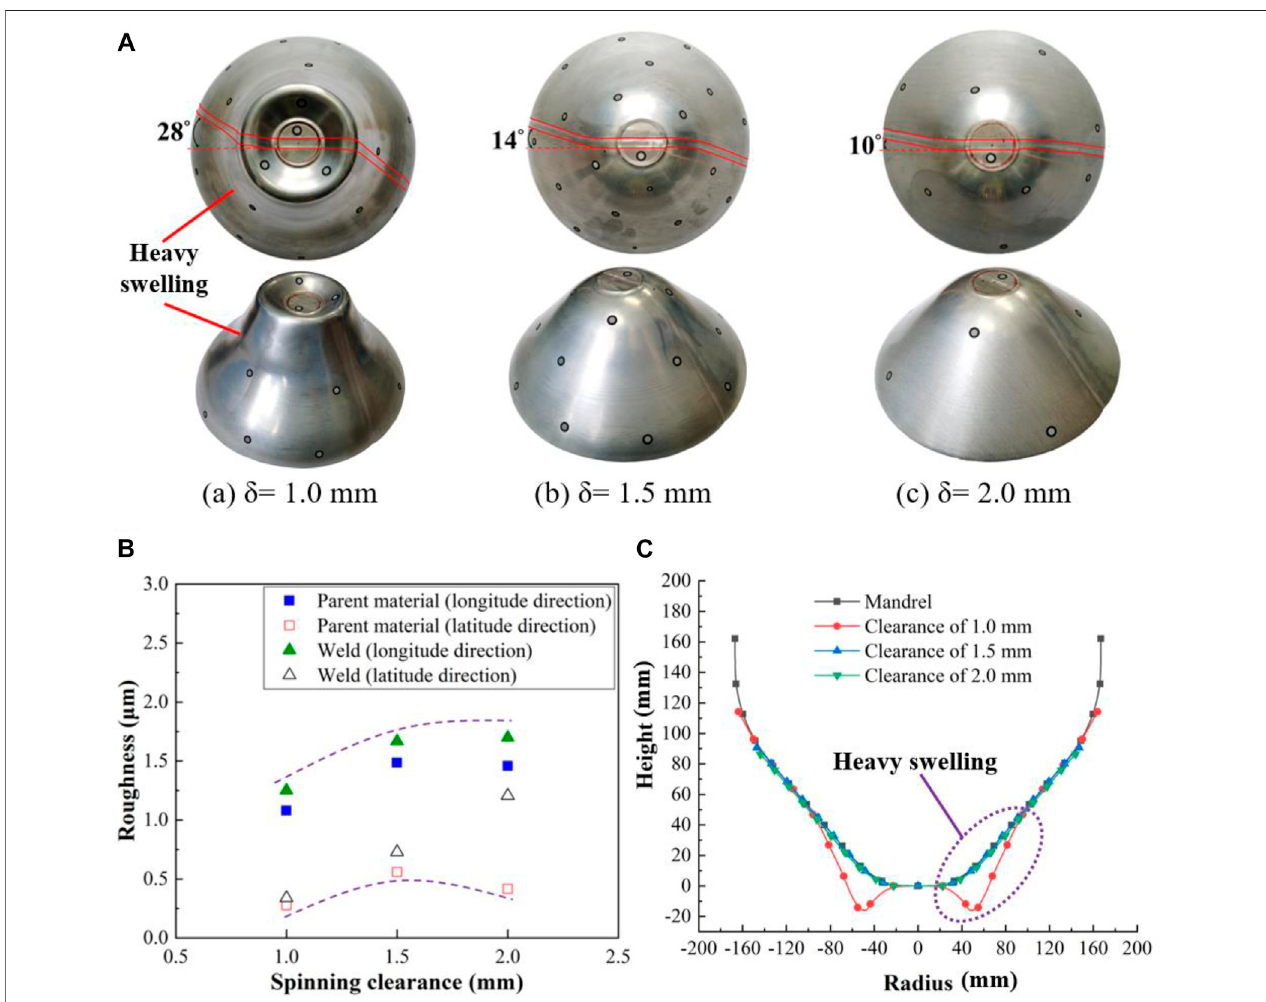
FIGURE 7 | Experimental results: (A) top and oblique views of spun parts under the spinning clearance of (a) δ (cid:1) 1.0 mm, (b) δ (cid:1) 1.5 mm, and (c) δ (cid:1) 2.0 mm; (B) surface roughnesses of spun parts and (C) forming pro fi le of spun parts.